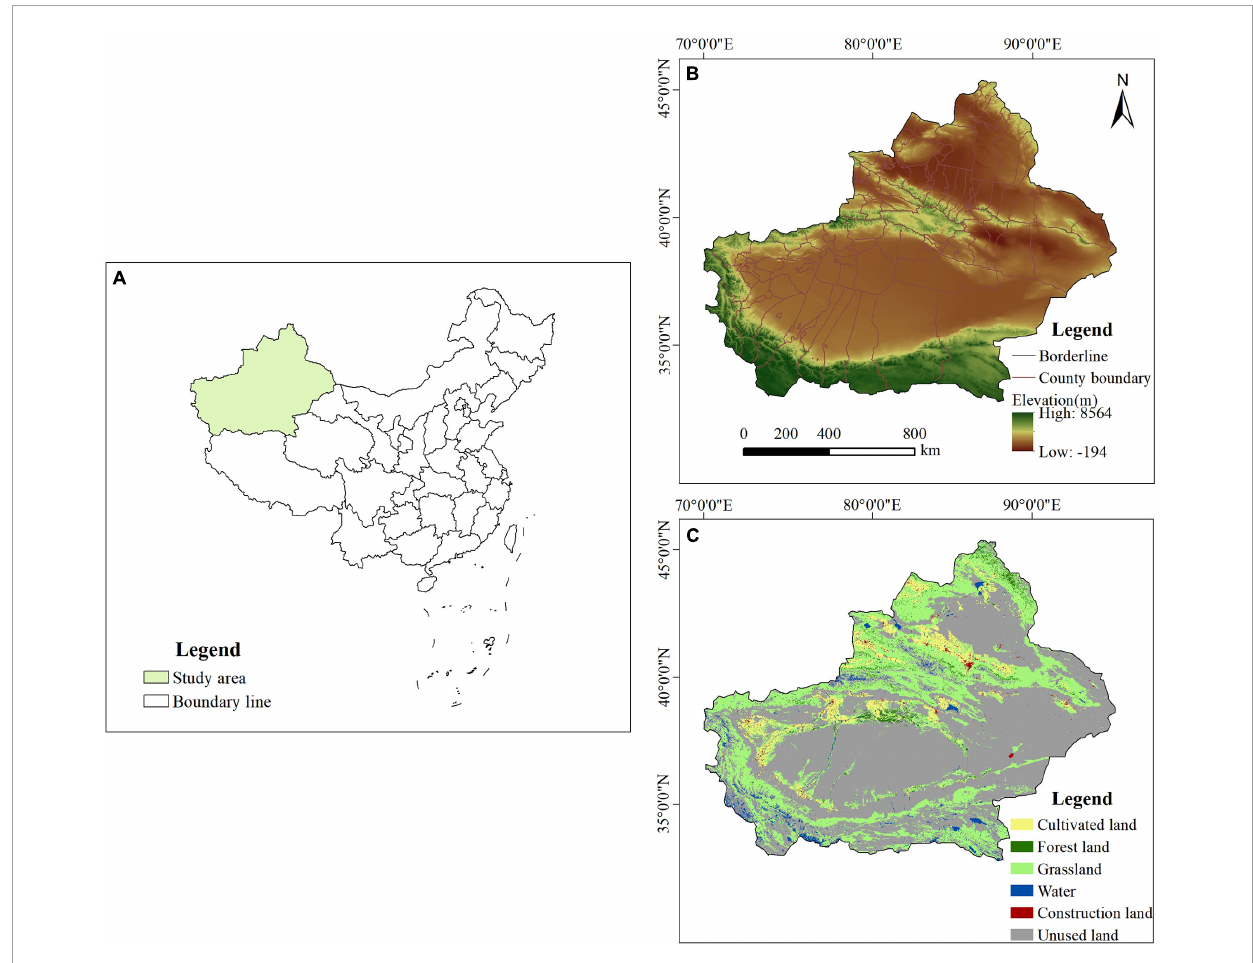
FIGURE1 Location, elevation, and land use type of the study area. (A) Xinjiang location. (B) Elevation. (C) Land use